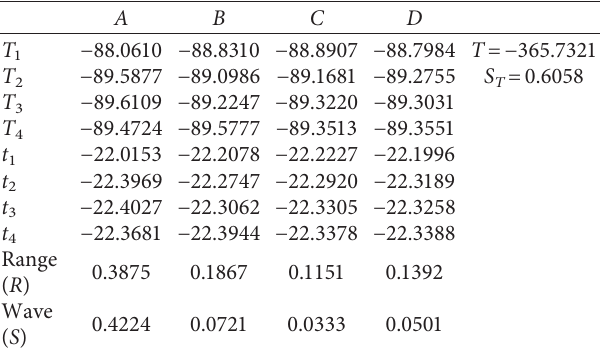
Table 9: Variance data